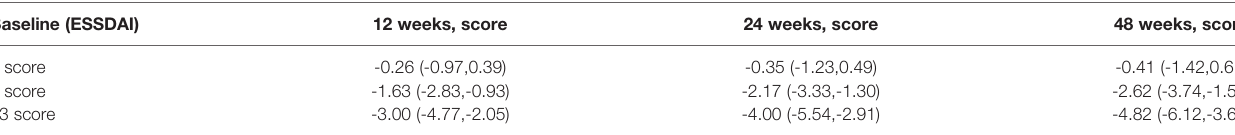
TABLE 3 | Model-estimated typical placebo response at different time points (median,